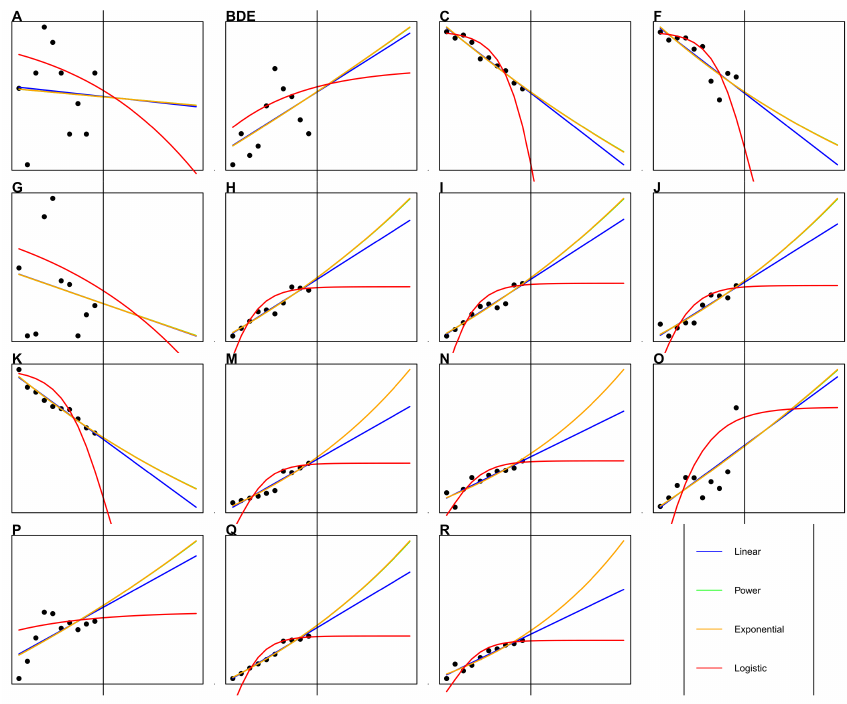
Figure 7: Employment prognosis for 15 industries in Goettingen